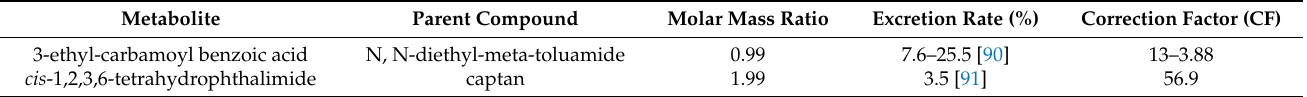
Table 2. Biomarkers to estimate human exposure to pesticides by influent wastewater analysis.